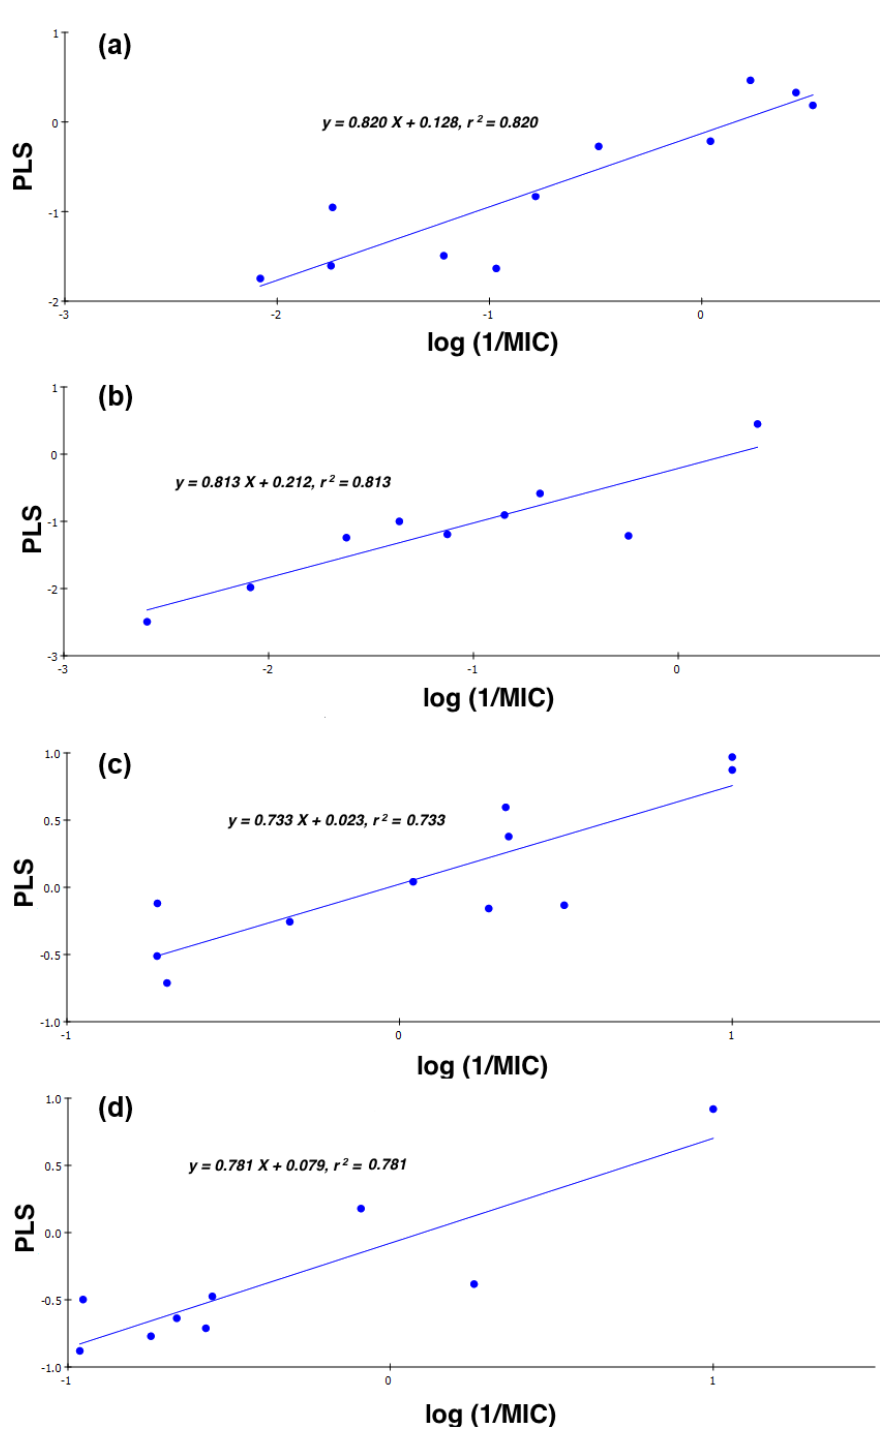
Figure 4. The Partial least squares (PLS) regression models for ( a ) CD-S: CIPRO derivatives against S. aureus ; ( b ) ND-S: NOR derivatives against S. aureus ; ( c ) CD-B: CIPRO derivatives against B. subtilis ; and ( d ) ND-B: NOR derivatives against B. subtilis